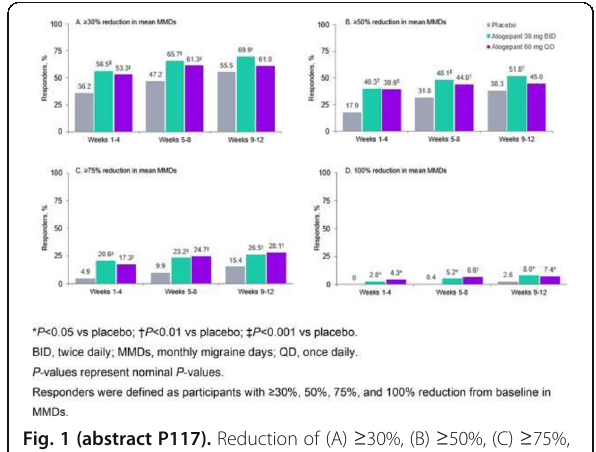
Fig. 1 (abstract P117). Reduction of (A) ≥ 30%, (B) ≥ 50%, (C) ≥ 75%, and (D) 100% in Mean MMDS BY 4-Week